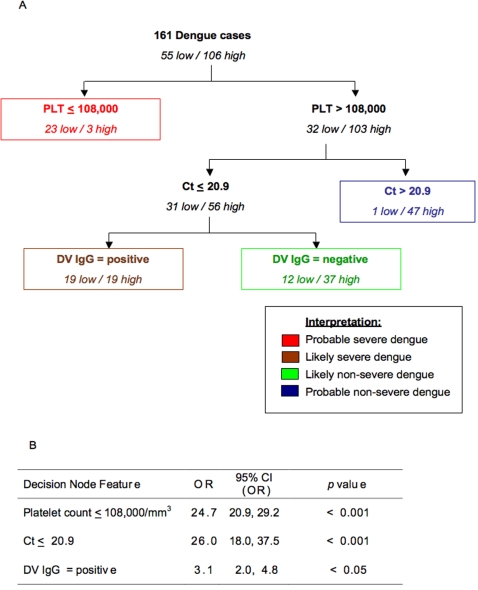
Decision algorithm for predicting severe dengue disease.A. Decision algorithm for severity prediction calculated on 169 patients with clinical data obtained at the first visit. PLT = platelet count; Ct  = viral load whereby a high Ct-value indicates a low viral load; DV IgG = indicator for primary/secondary infection whereby a positive result indicates a secondary infection. Low = platelet nadir of 50,000/mm3 or less; high = platelet nadir greater than 50,000/mm3. The prediction of the algorithm is shown in colours: Red indicates probably severe dengue; brown indicates likely severe dengue; green indicates likely non-severe dengue and blue indicates probable non-severe dengue B. Statistical (chi square) analysis of splitting criteria performed on each subgroup at the decision nodes. OR = odds ratio; CI = 95% confidence interval.. PLT = platelet count; Ct = crossover threshold value of real-time RT-PCR and indicative of level of viremia; DV IgG = indicator for primary/secondary infection whereby a positive result indicates a secondary infection; OR = odds ratio; CI = confidence interval.